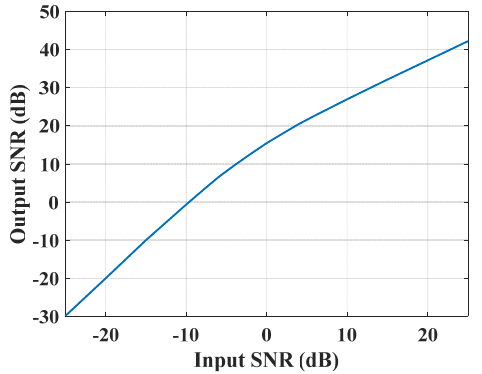
Figure 11. Relationships of input and output SNRs. Table 3. Parameters of experimental data.